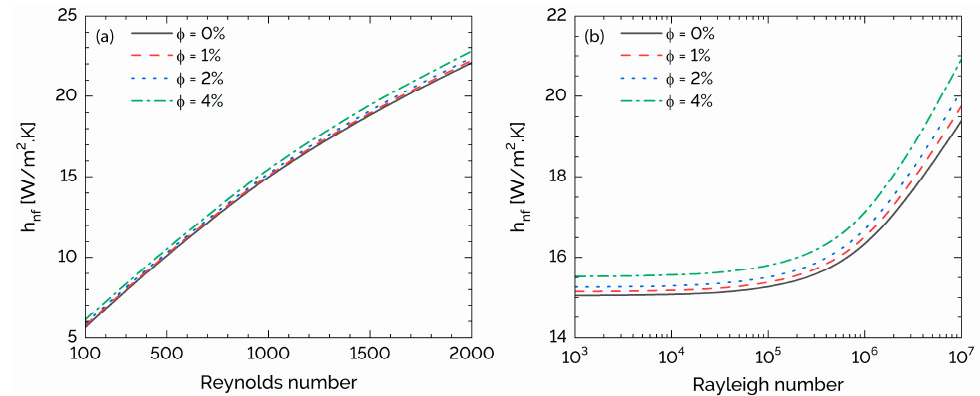
Figure 8. Convective heat transfer coefficient ( h nf ) with Reynolds and Rayleigh numbers for four values of CuO-nanoparticle concentrations. ( a ) Reynolds number and (b ) Rayleigh number. values of CuO-nanoparticle concentrations. ( a ) Reynolds number and ( b ) Rayleigh number.